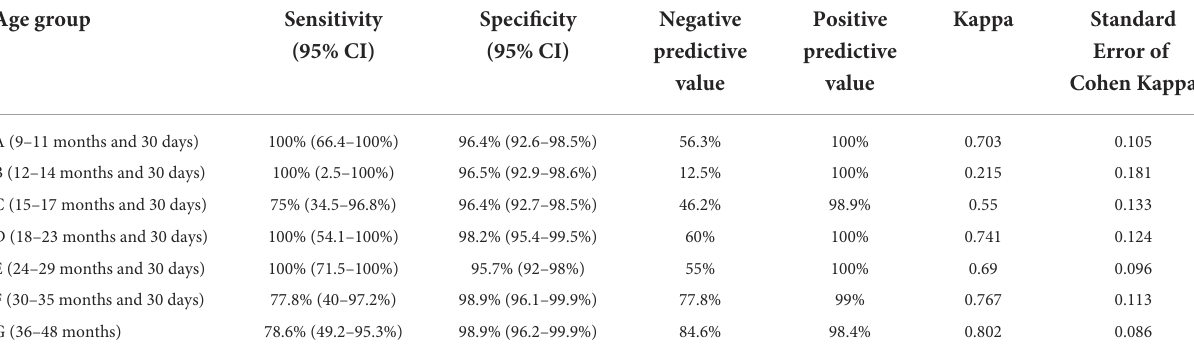
TABLE 4 Sensitivity, specificity, positive predictive value, negative predictive value, and kappa measure of agreement of the Dubai Tool for Developmental screening (DTDS) compared with the Parent’s Evaluation of Developmental Status (PEDS) tools. Age group